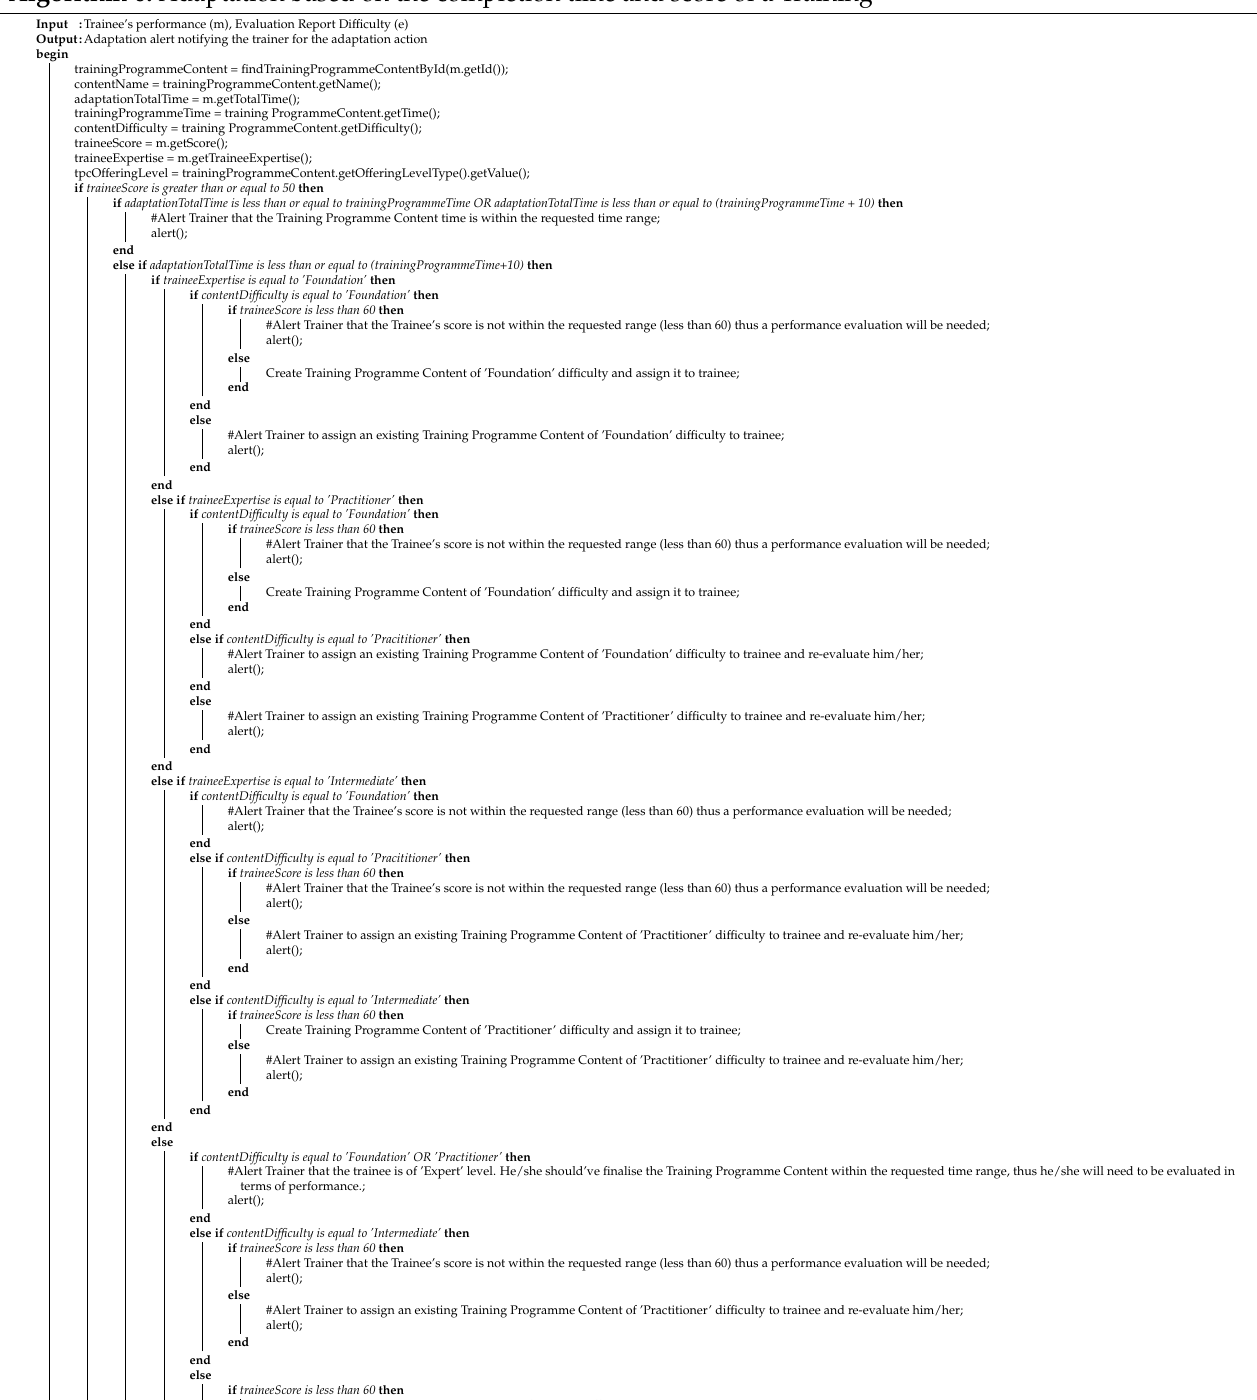
Algorithm 6: Adaptation based on the completion time and score of a